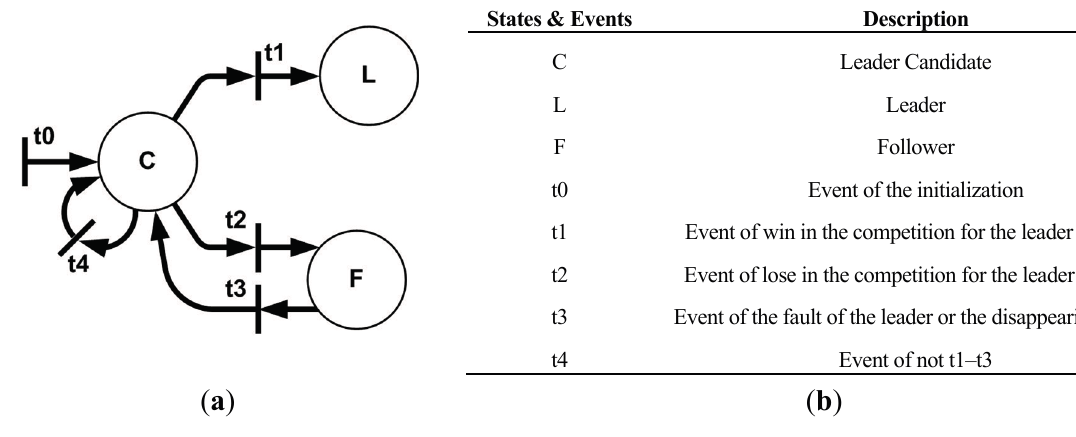
Figure 3. The task assignment of LC. ( a ) The task assignment process; ( b ) States and events in